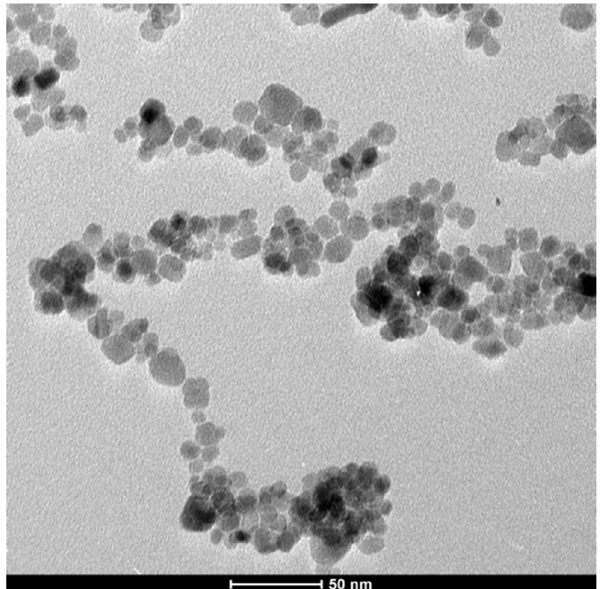
Figure 1. HR-TEM image of the prepared MNPs capped with ascorbic acid shows that particles have spherical shape with average size of 20.0 ± 2.0 nm.